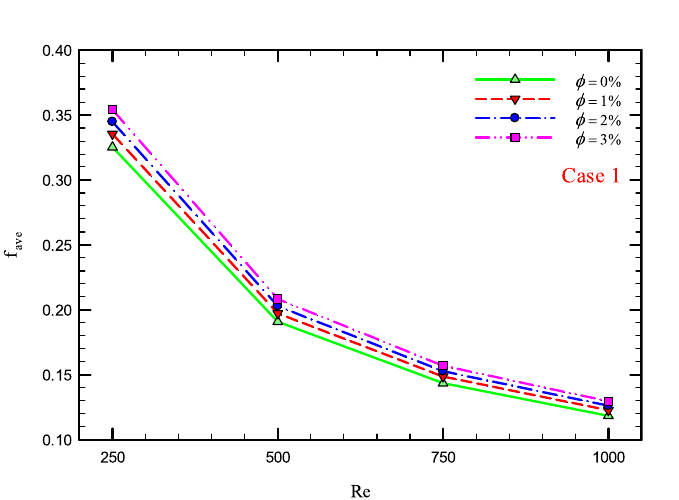
Figure 37. f ave versus Re for Case